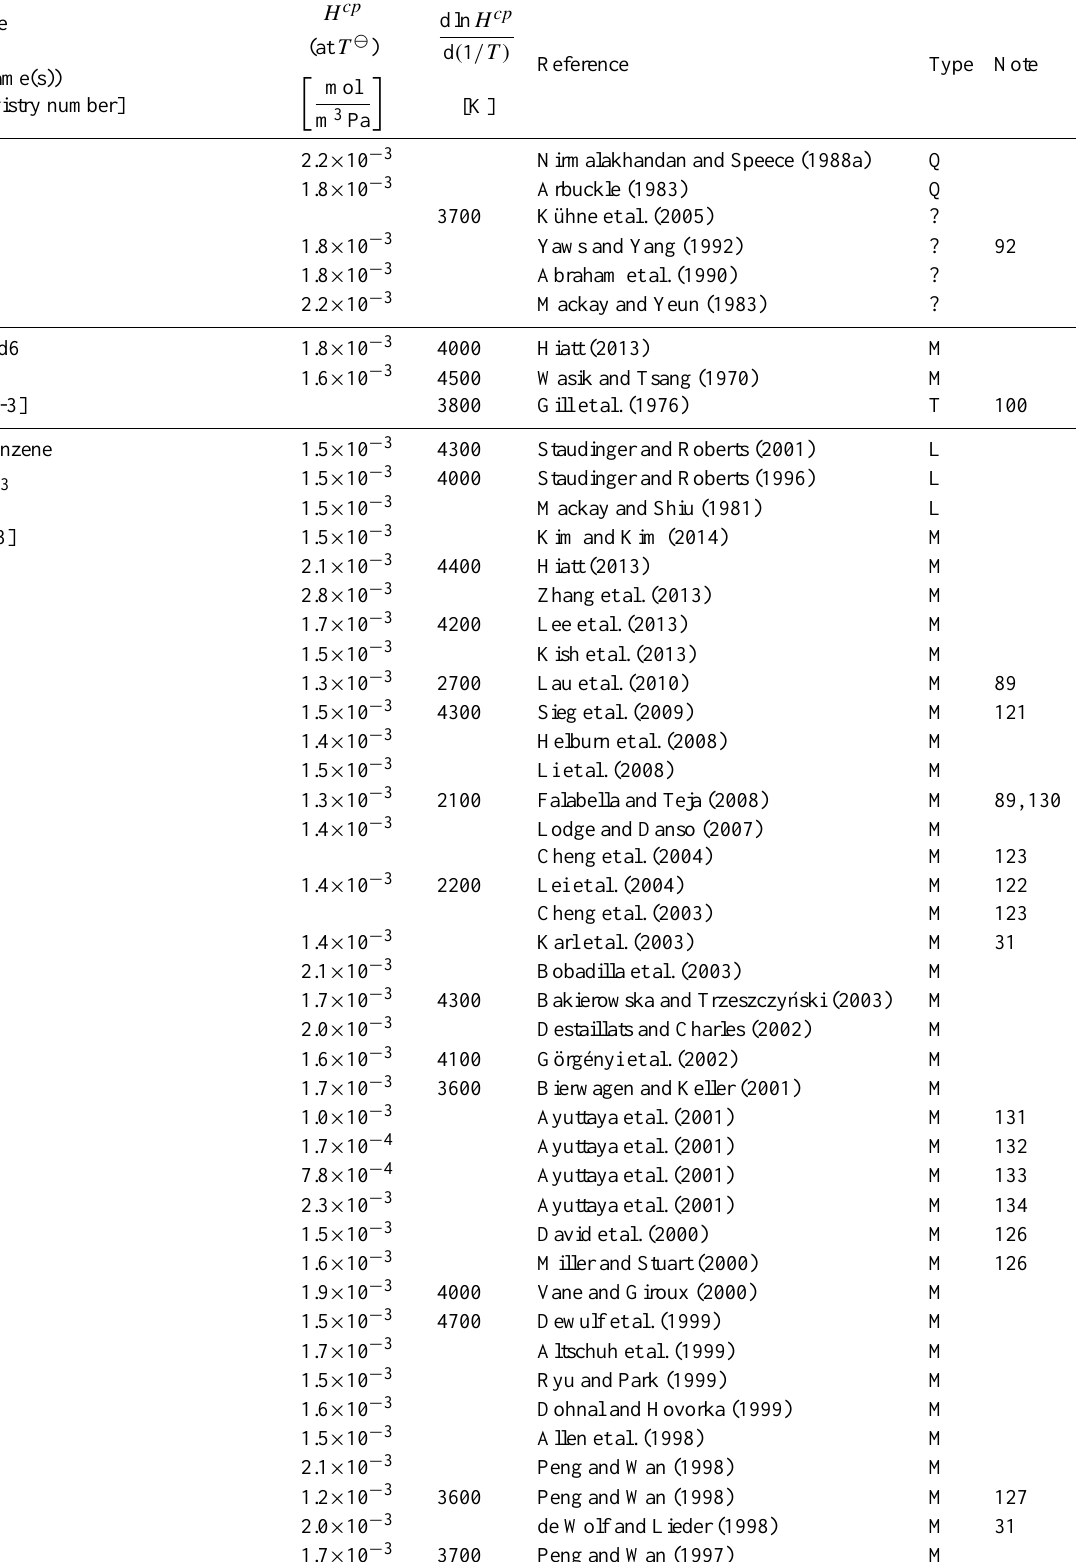
Table 6: Henry’s law constants for water as solvent